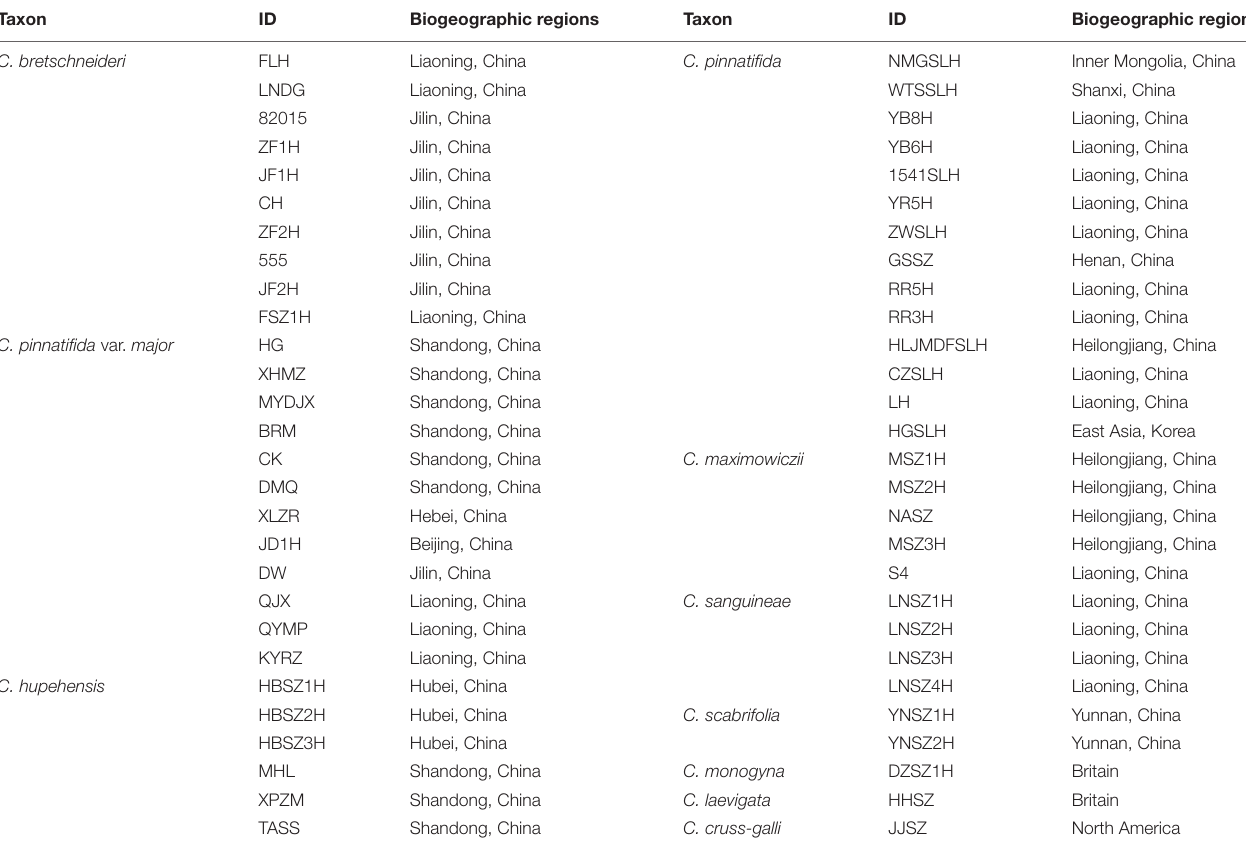
TABLE 1 | Details of geographic and sampling information for Crataegus investigated in this